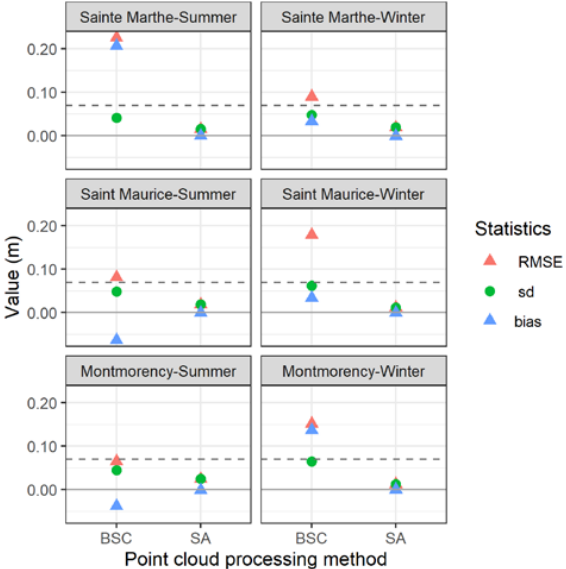
Figure 8. Relative error statistics between overlapping flight